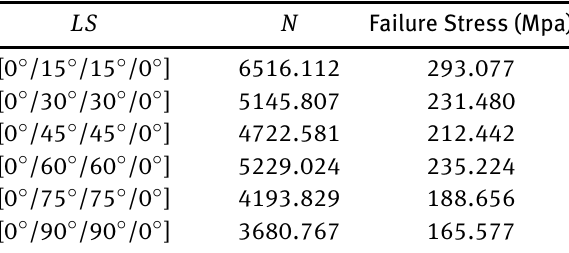
Table 2: Experimental failure load ( N ) for different lamination schemes ( LS ) [0 ◦ / θ ◦ / θ ◦ /0 ◦ ] with θ (= 15, 30, 45, 60, 75, 90 ◦ ) of composite plate with 1.235 mm thickness [8].